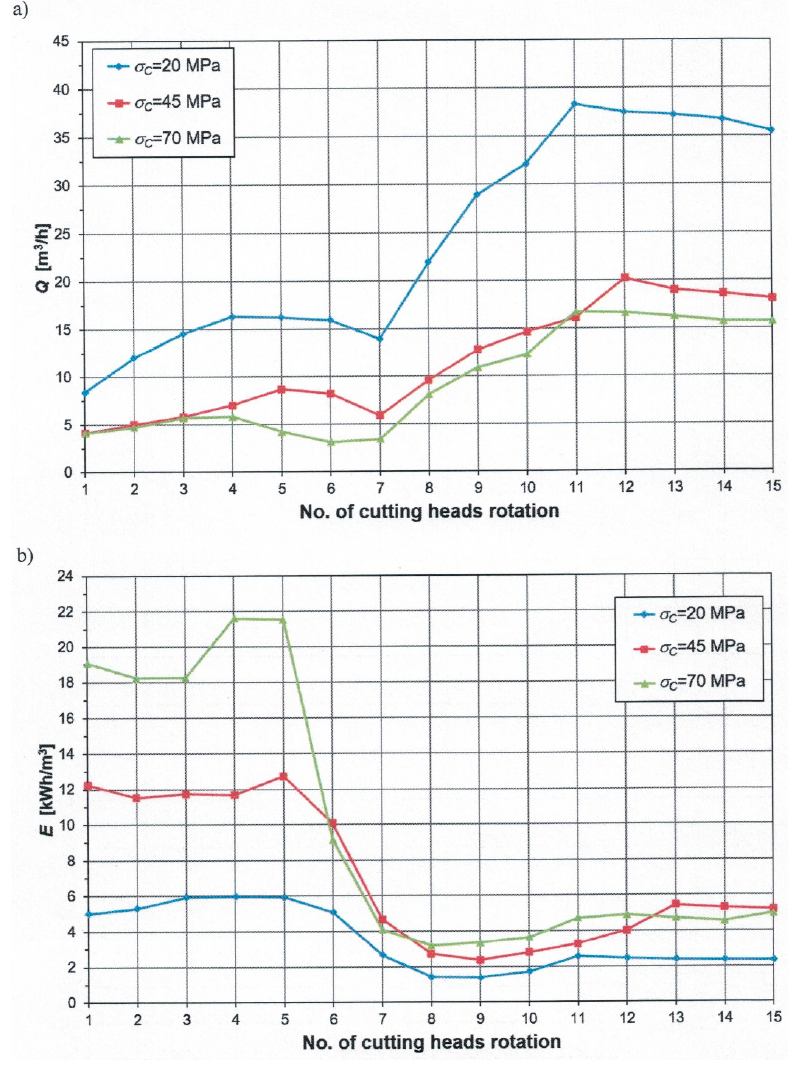
Figure 6. The course of: ( a ) mining efficiency ( Q ) and ( b ) mining energy consumption ( E ) in subsequent rotations of the cutting heads when making lower cuts in the automatic control mode in rocks with different uniaxial compressive strengths.